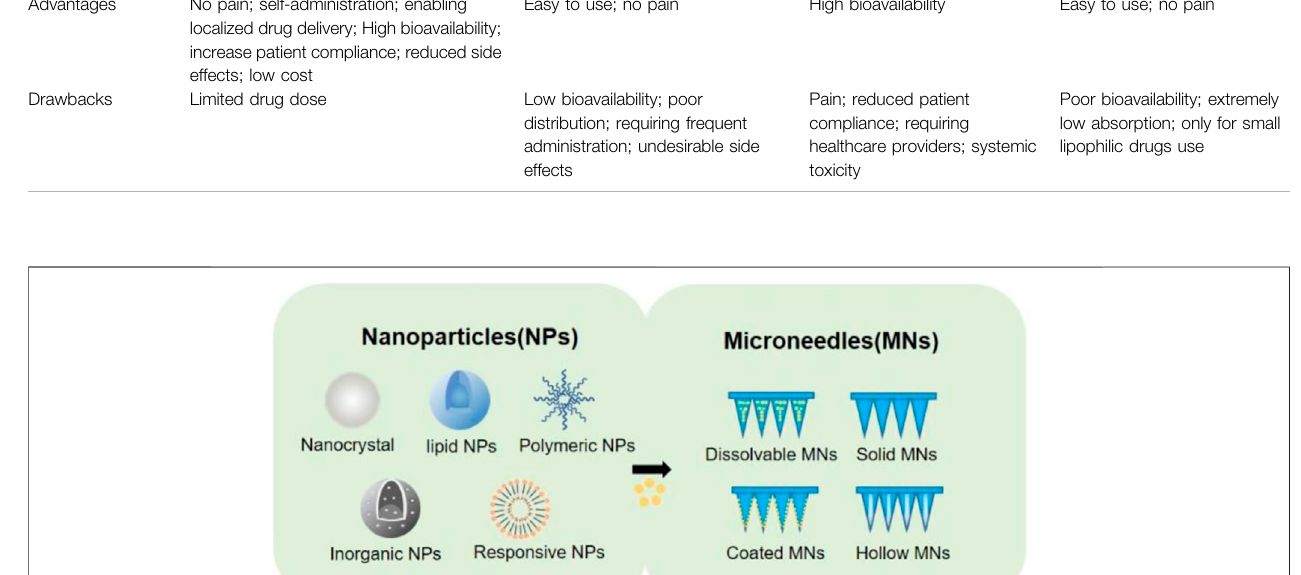
TABLE 1 | The comparison of different administration routes for drug-carrying nanoparticles. Administration routes